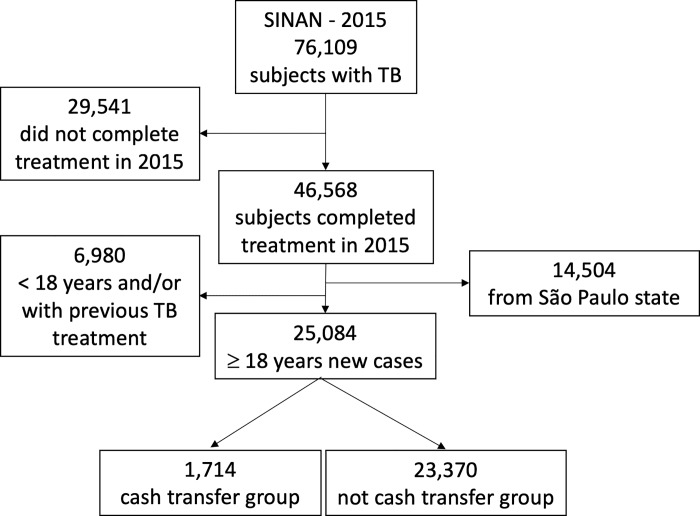
Flowchart of study sampling of people from the Brazilian Notifiable Disease Information System database (SINAN), 2015.